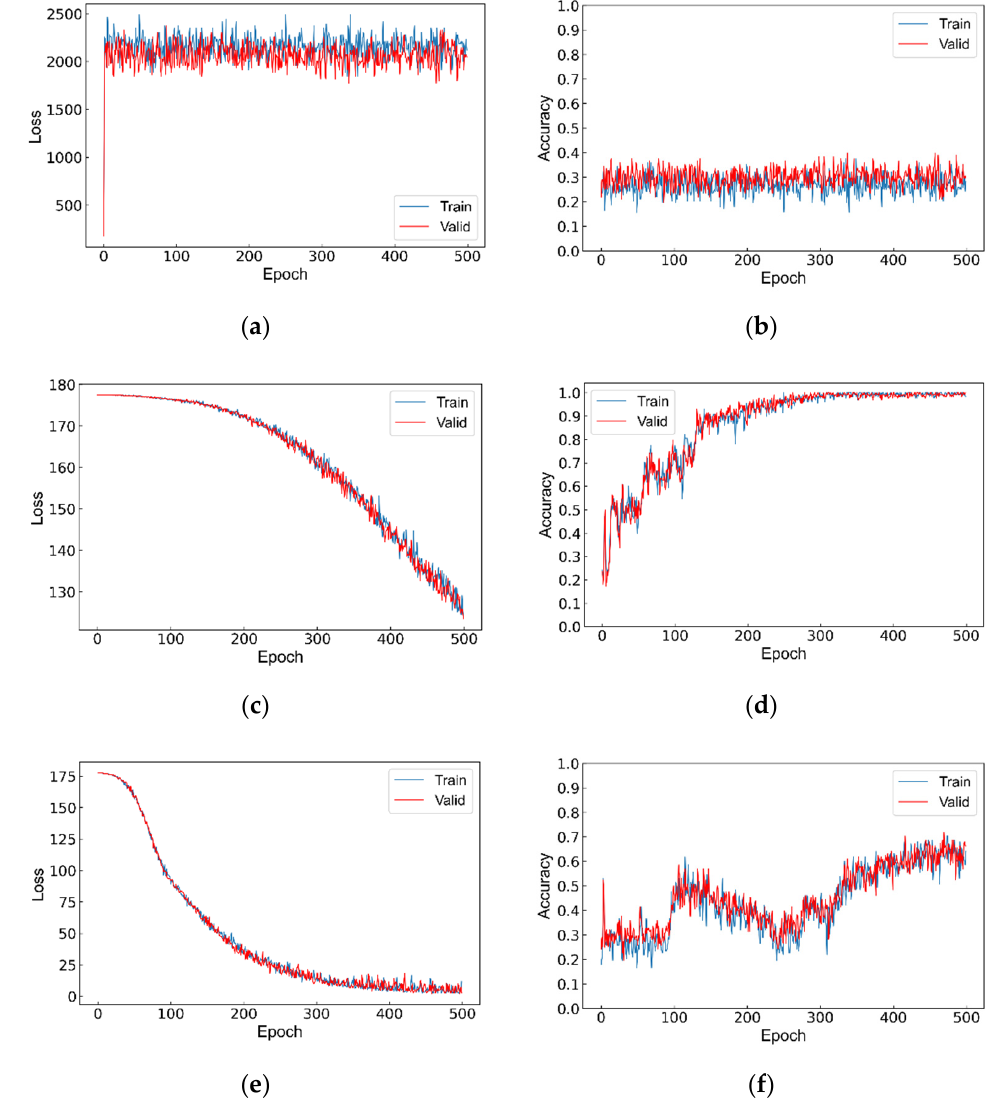
Figure 10. Using Adam to train the model with different learning rates. ( a , b ) learning rate = 1 × 10 − 3 ; ( c , d ) learning rate = 1 × 10 − 4 ; ( e , f ) learning rate = 1 × 10 − 5 .